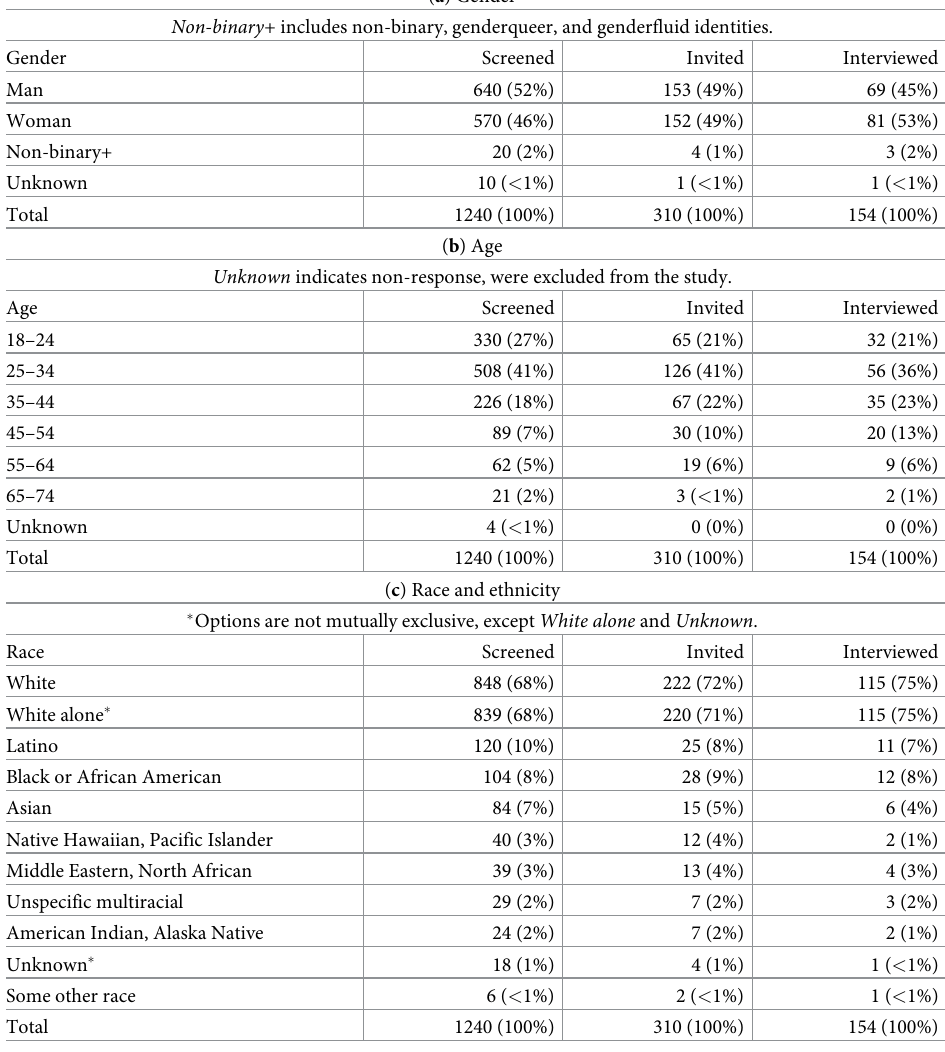
interview. Percentages are column-wise. For example, of those who were screened, 10% were Latino. Of those who were invited to interview, 7% were